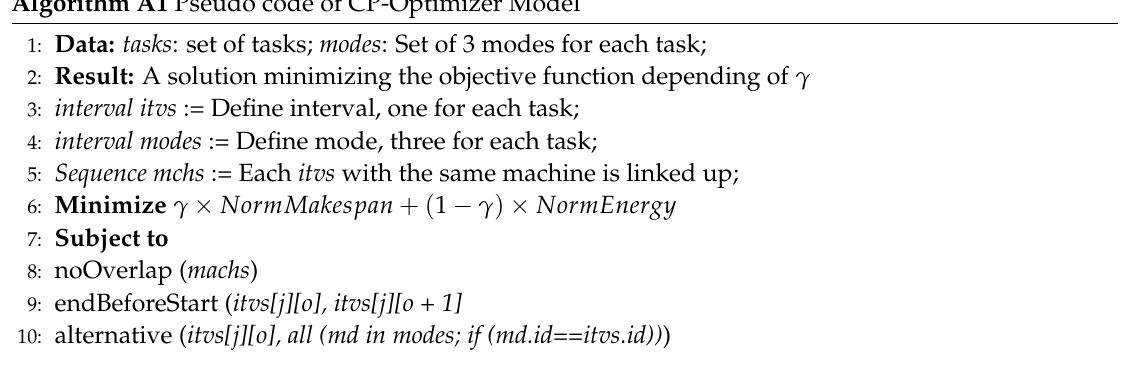
Algorithm A1 Pseudo code of CP-Optimizer